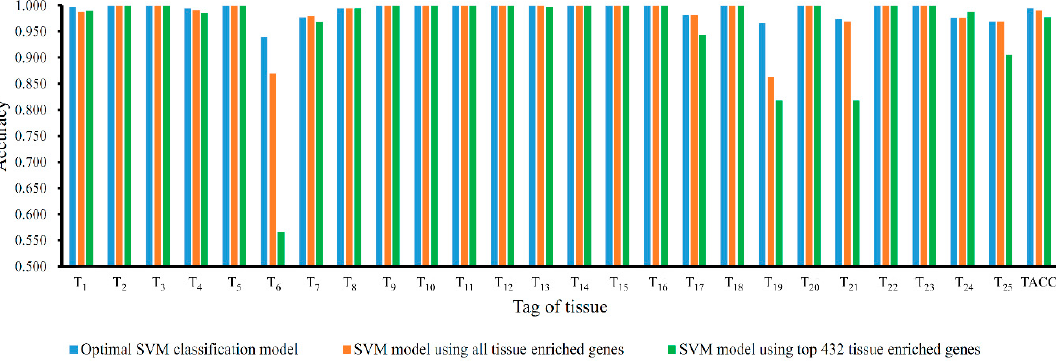
Figure 2. The performance of the optimal support vector machine (SVM) classification model, SVM model using all tissue enriched genes and SVM model using top 432 tissue enriched genes, including accuracy on each tissue and overall accuracy. The optimal SVM classification model gave better performance.